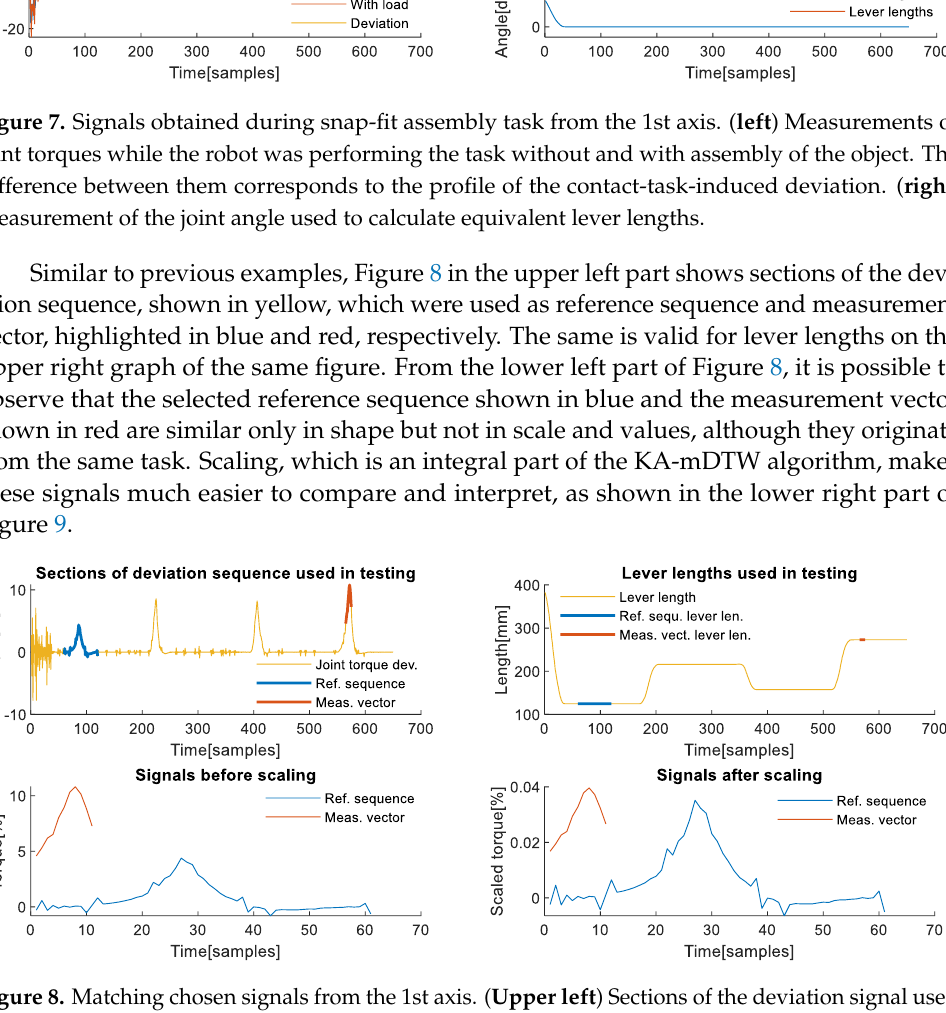
Figure 8. Matching chosen signals from the 1st axis. ( Upper left ) Sections of the deviation signal used as reference sequence and the measurement vector during analysis. ( Upper right ) Sections of the lever lengths corresponding to chosen testing signals. ( Lower left ) Signals used as reference sequence and measurement vector in their original values prior to scaling by the algorithm. ( Lower right ) Signals used as reference sequence and measurement vector after scaling was applied. Figure 9 in the upper left part shows that the observed signals shown in blue and red were correctly matched, which is confirmed by the error signal shown in the yellow and cumulative matching error of 0.0207. The reference sequence segment corresponding to the measurement vector was correctly identified, as highlighted on the upper right part of the same figure, indicating that the contact task dynamics would be correctly interpreted. The most striking observation is that the mDTW algorithm is powerless in this situation and only manages to match the entire measurement with a single point from the reference sequence, which can be seen in the lower left and middle parts of Figure 9. Although striking, this result from mDTW is expected, and it is truly the best result it could theoretically achieve. Nevertheless, the error shown in yellow on the lower left graph has a cumulative value of 0.3106, which is significantly higher than with KA- mDTW. However, the biggest implication of this matching is that the contact force would be completely wrongly interpreted and would surely indicate some erroneous state.